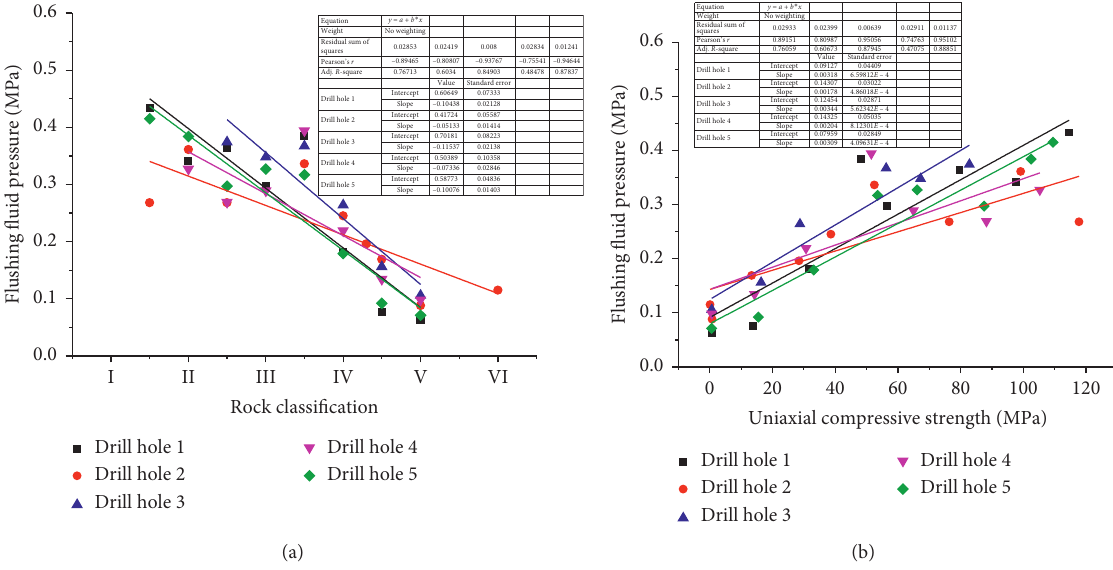
Figure 12: Relationship between rock classification, compressive strength, and flushing fluid